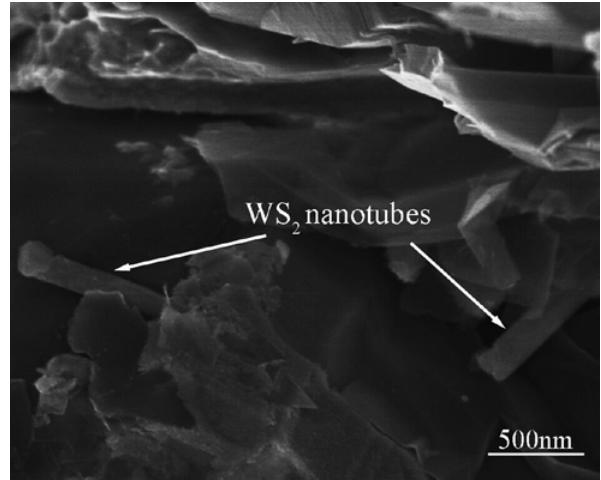
Figure 4: Scanning electron microscopy (SEM) image of frac- ture morphology of Cu-WS (Cu-WS 2